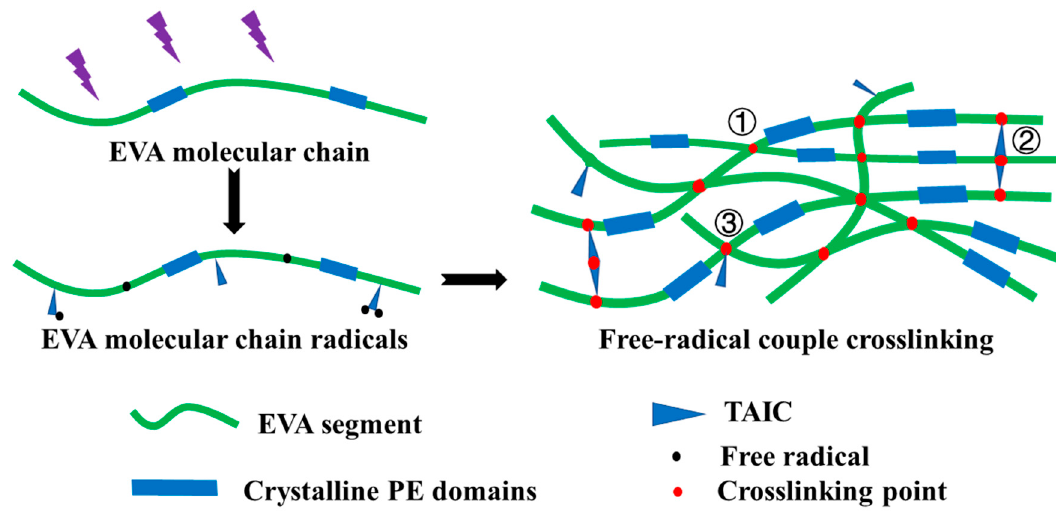
Figure 2. Schematic illustration of the crosslinking EVA fiber via free radical reaction initiated by UV.